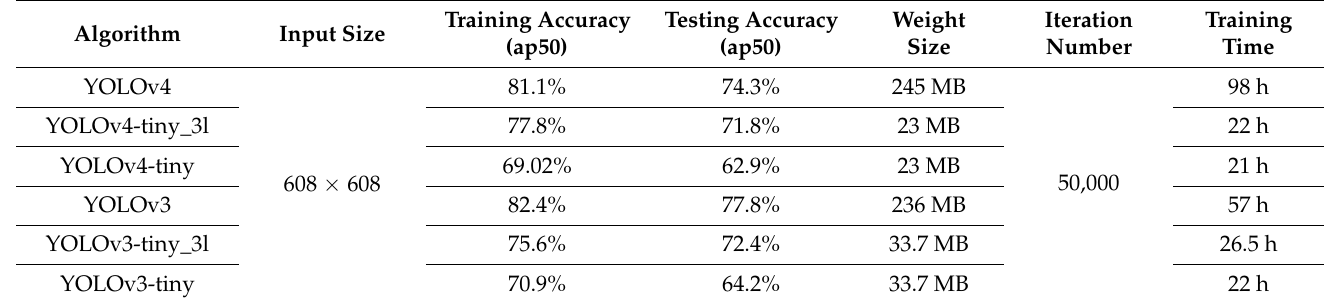
Table 3. Making pretrained weights using a limited